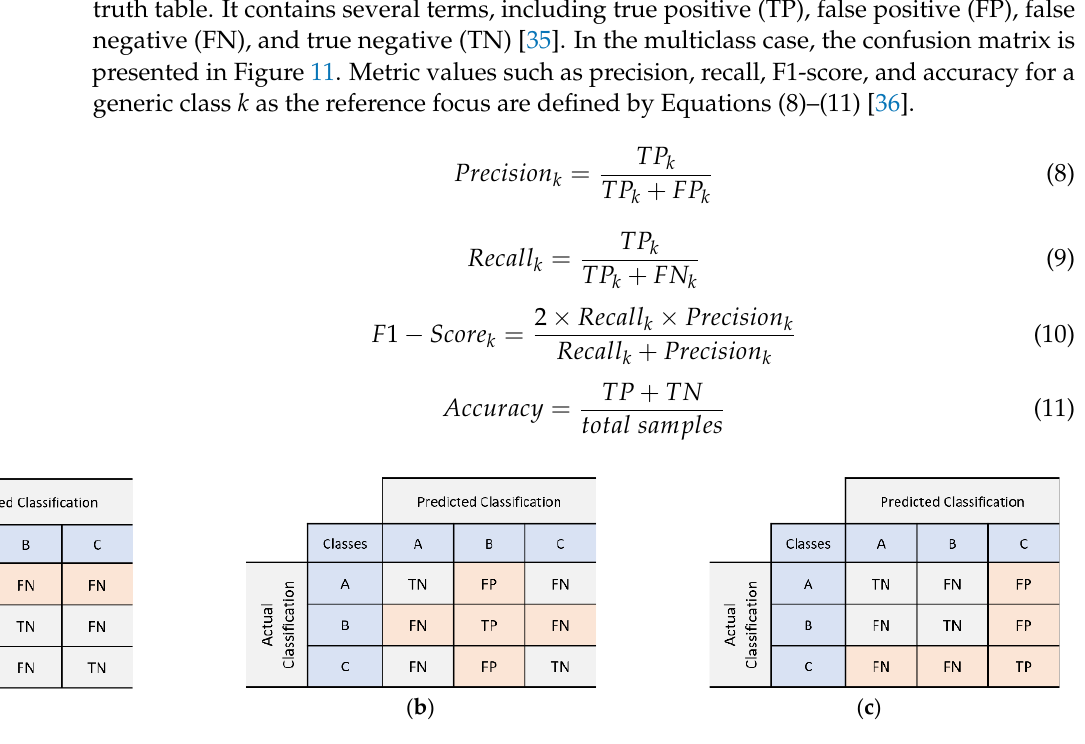
Figure 11. An example of confusion matrix: ( a ) focusing on class ‘A’; ( b ) focusing on class ‘B’; ( c ) focusing on class ‘C’.